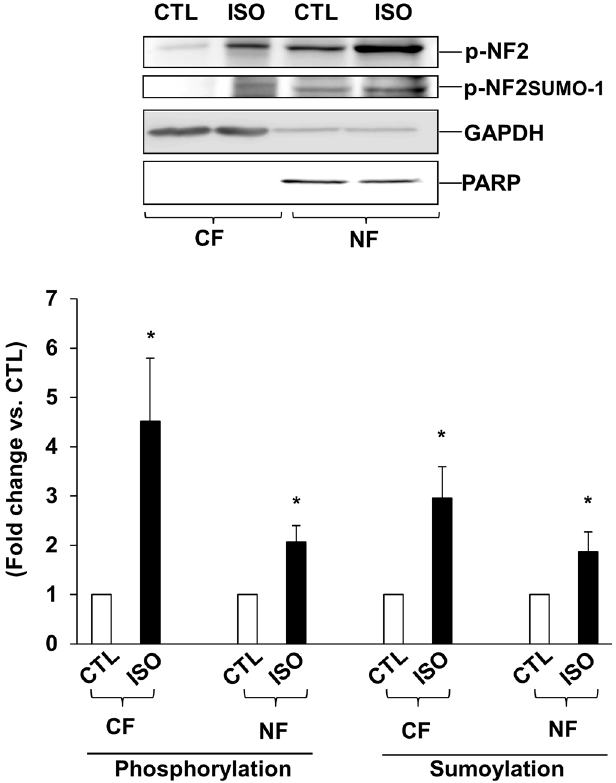
blot using phospho-specific anti-NF2 antibodies. The lower panels exhibit the mean data normalized to GAPDH (CF) or PARP (NF), (cid:3) p < 0.05 vs CTL; n =